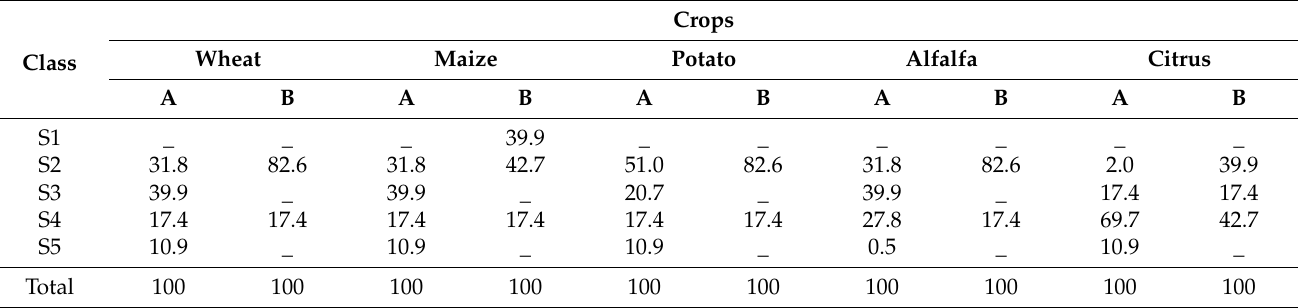
Table 4. The soil suitability for the five crops